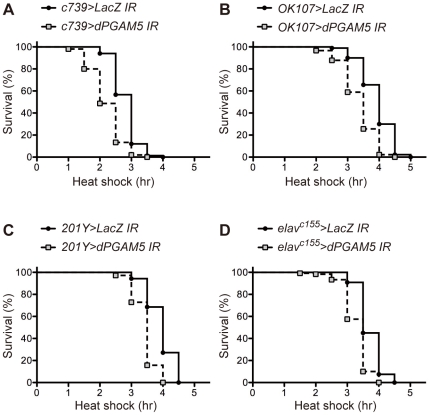
Deficiency of dPGAM5 in the MB induces vulnerability to HS.Knockdown of dPGAM5 in the MB (A–C) and pan-neuronal knockdown of dPGAM5 (D) induce vulnerability of flies to HS. Survival curves of adult male c739>dPGAM5 IR flies (c739-GAL4/UAS-dPGAM5 IR, n = 150; A), OK107>dPGAM5 IR flies (UAS-dPGAM5 IR/+; OK107-GAL4/+, n = 90; B), 201Y>dPGAM5 IR flies (201Y-GAL4/UAS-dPGAM5 IR, n = 70; C) and elavc155>dPGAM5 IR flies (elavc155-GAL4/Y; UAS-dPGAM5 IR/+, n = 120; D) subjected to HS are shown. LacZ IR vs. dPGAM5 IR in each group, p<0.0001 by the log-rank test.